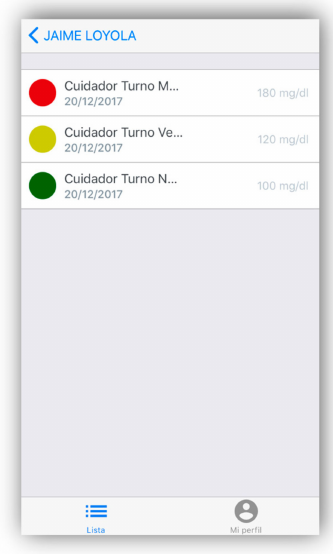
Figure 9. Alerts with color codes according the sensed data by the bracelet.